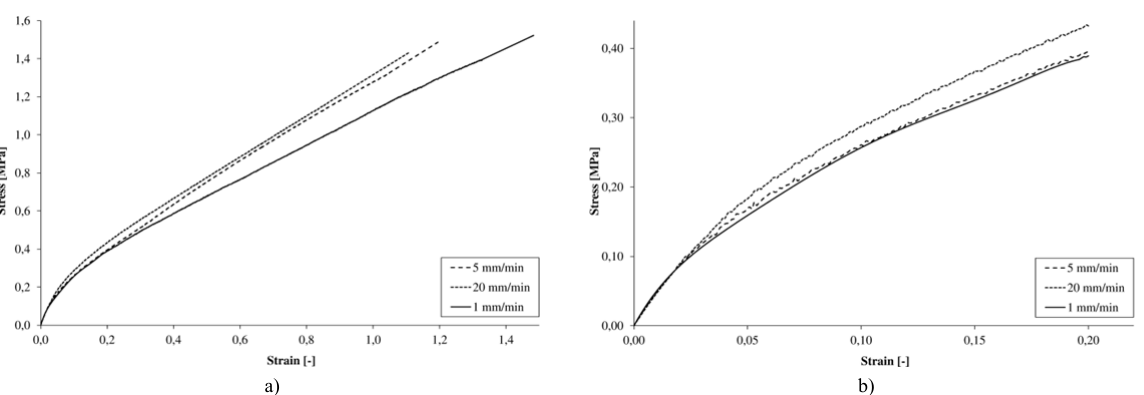
Fig. 5a) Average tensile stress-strain curve for different displacement rates and b) Initial tensile stress-strain relationship up to a strain of 0.2.